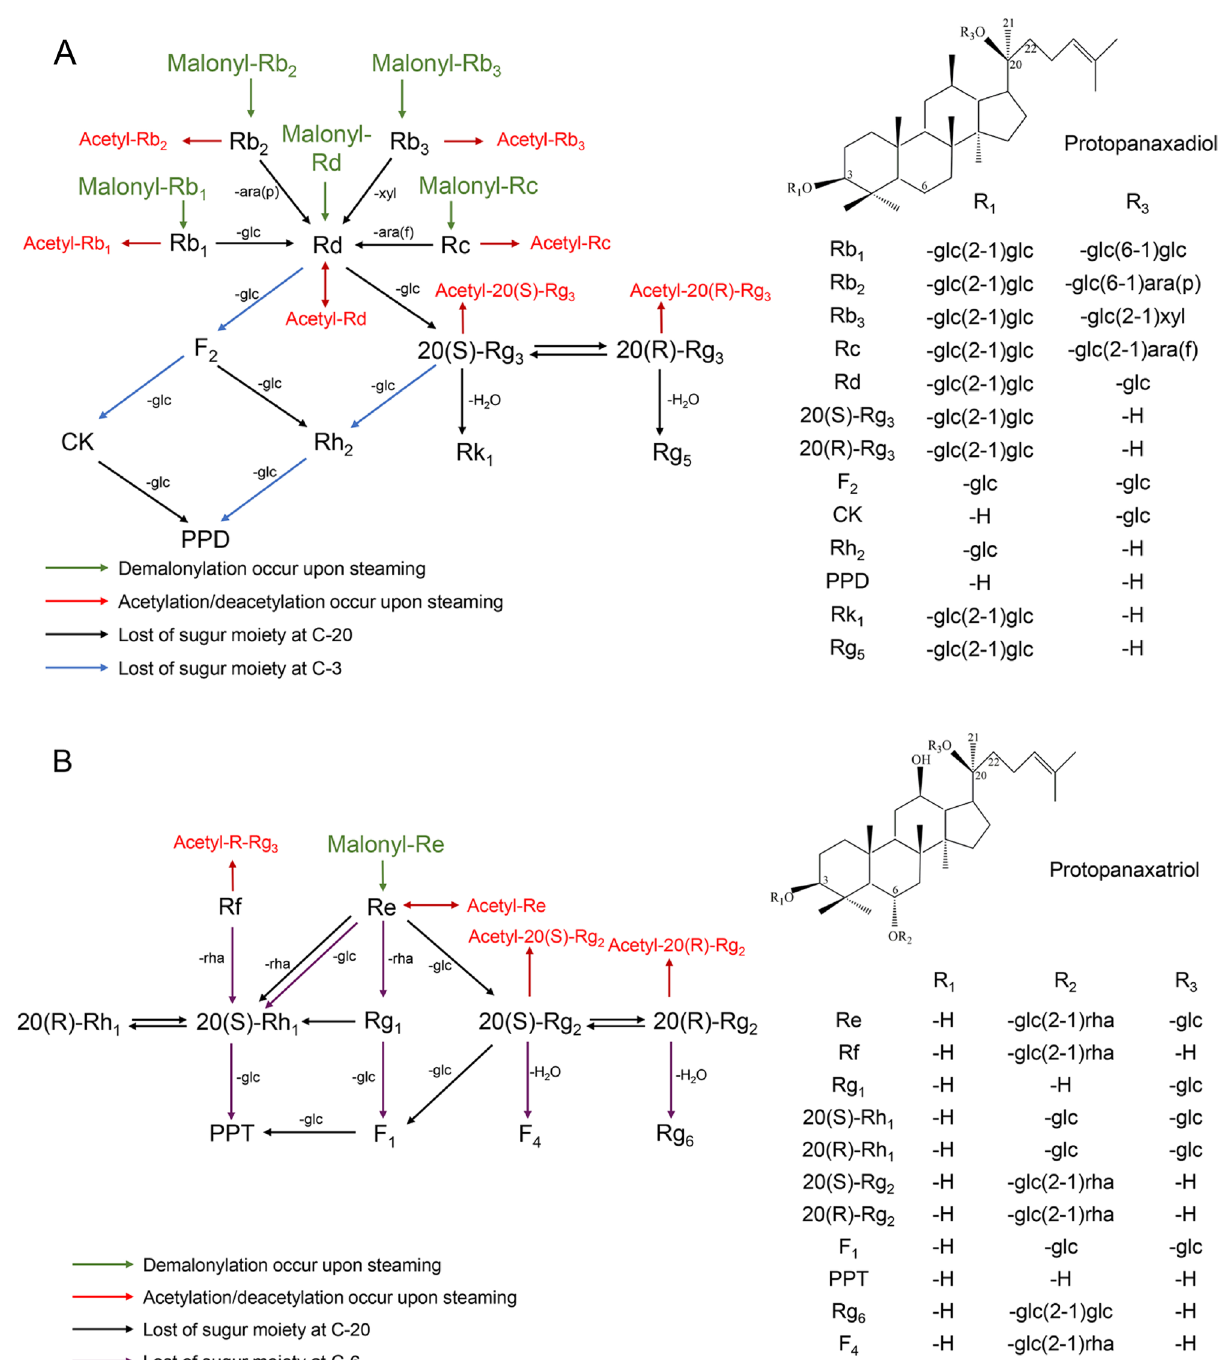
Figure 4. Chemical structures and possible transformation mechanisms of ginsenosides identified from raw and steamed ginseng pulps extracts (GPE) and/or extracts from ginseng pulp soaking supernatant (GPS). ( A ) Protopanaxadiols; ( B ) Protopanaxatriols. ara(f), α-l-arabinofuranosyl; ara(p), α-l-arabinopyranosyl; glc, β-d- glucopyranosyl; xyl, β-l-xylopyranosyl; rha, α-l-rhamnopyranosyl. Chemical links between C-20 and C-22 of F 4 and Rg 5 , and between C-20 and C-21 of Rg 6 and Rk 1 are double